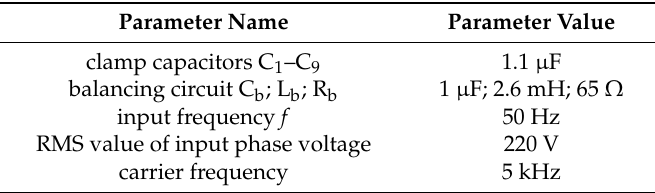
Table 2. Experimental Parameters.